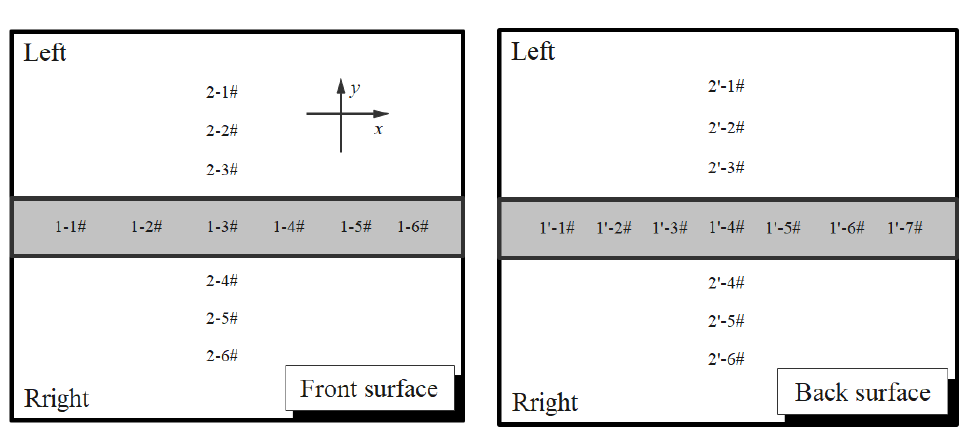
Figure 7. Positions for residual stress measurement.